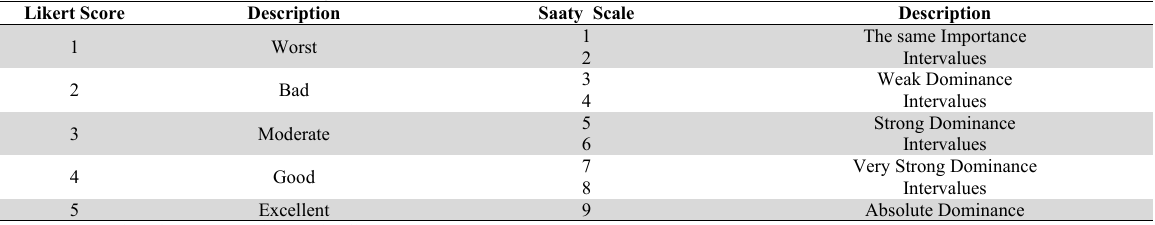
Likert Scale Score and AHP Rating